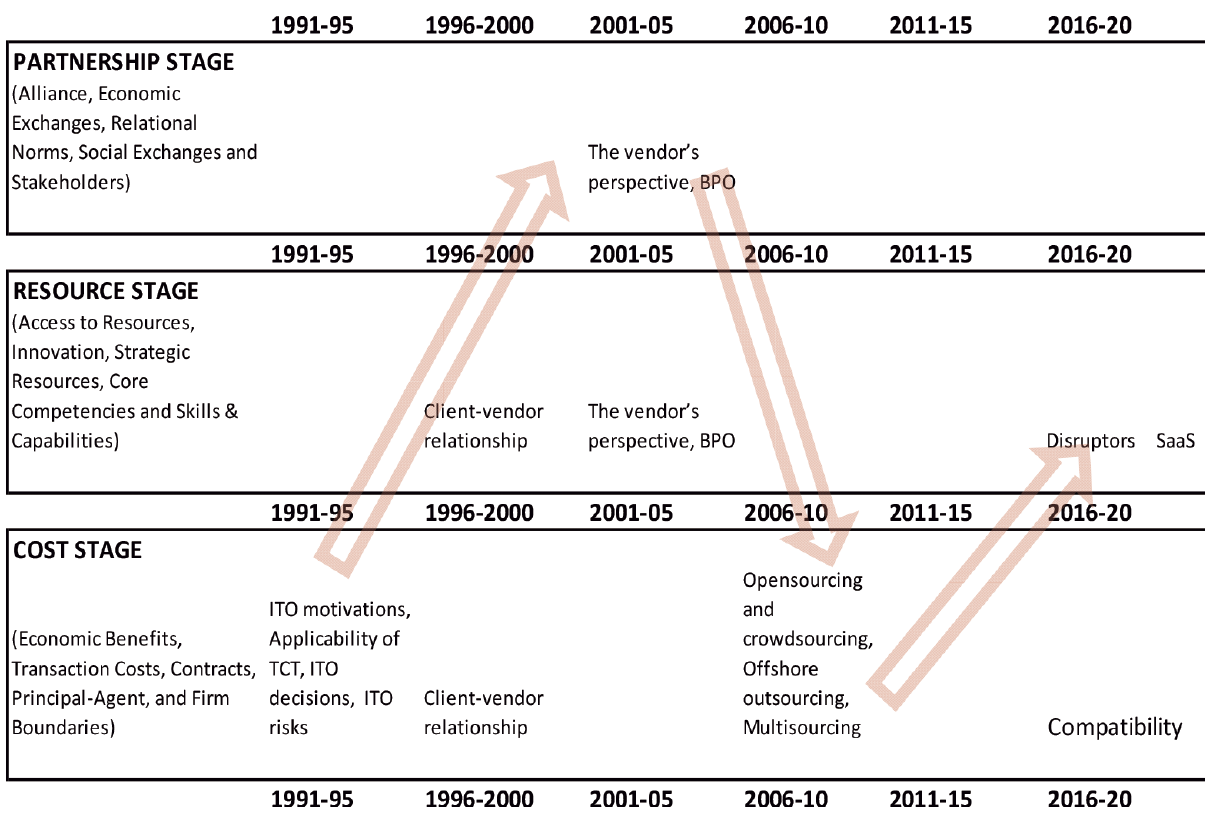
Figure 3. Development of ITO research